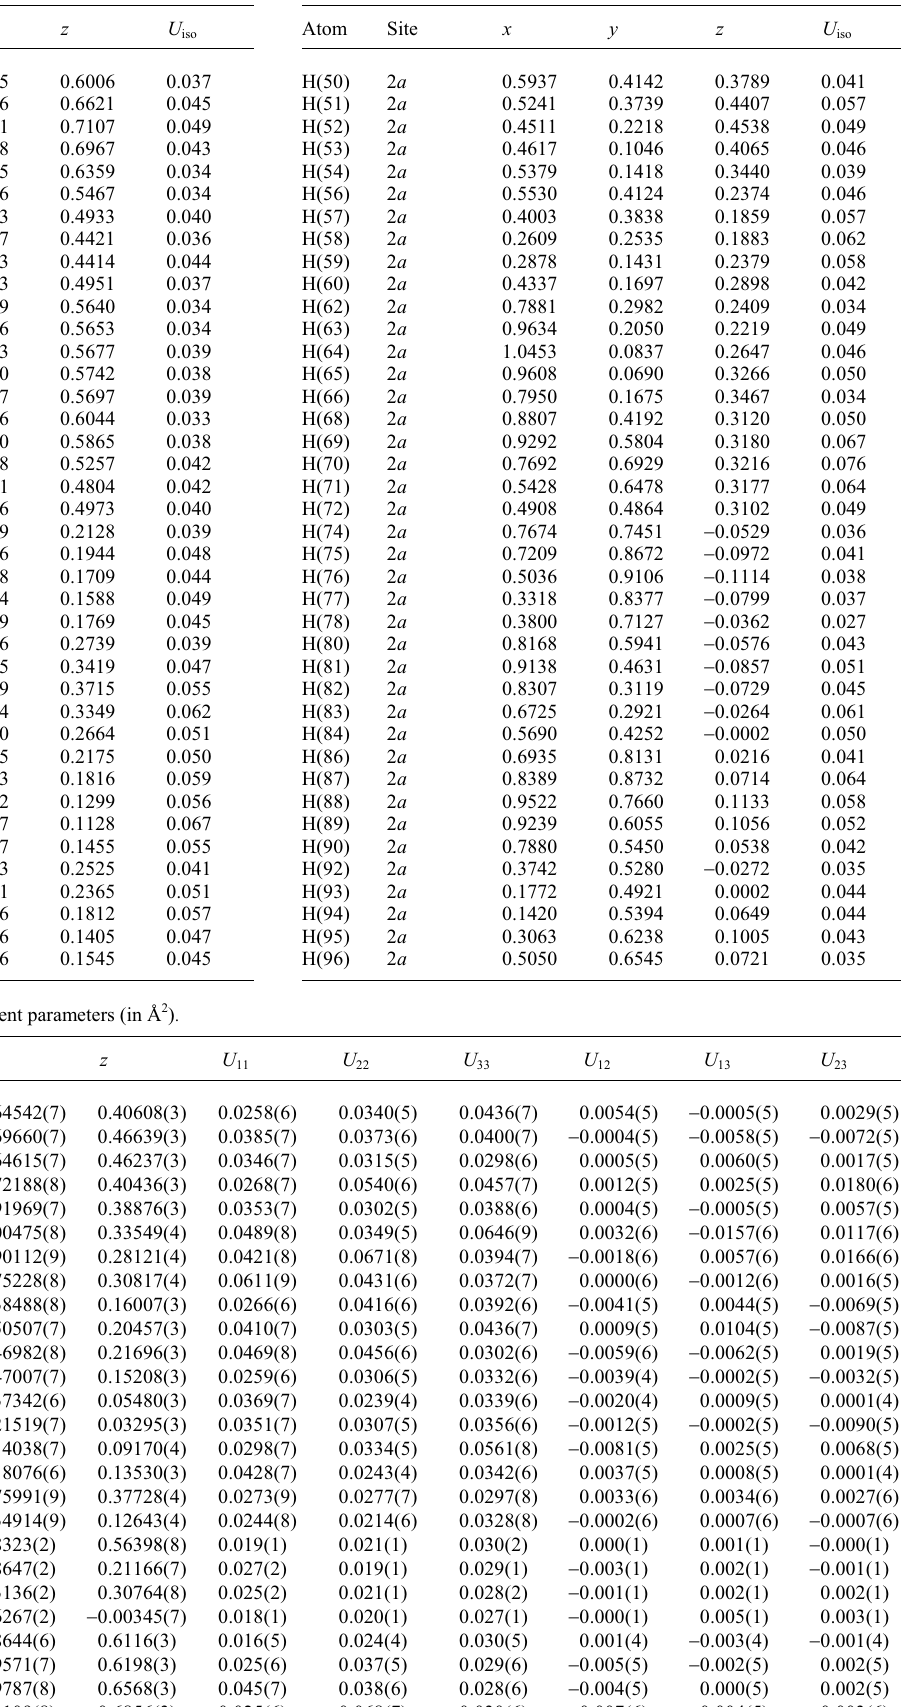
Table 2. Atomic coordinates and displacement parameters (in Å 2 ) .